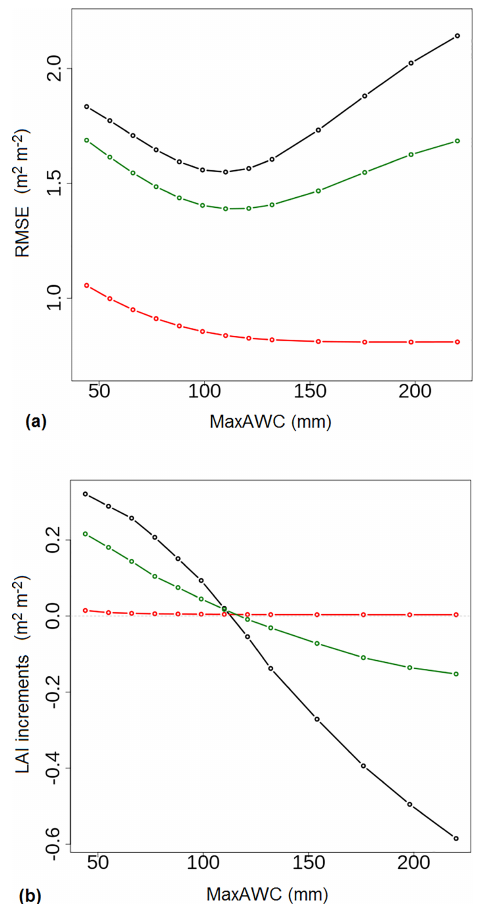
Figure 4. Mean cost function values vs. MaxAWC across all 45 départements of (a) inverse modelling and (b) LDAS tuning experi- ments for three different optimisation periods: (red) start of growing period (from 1 March to LAI max date); (green) peak LAI (dates for which LAI > 0.5 LAI max ) ; (black) senescence (from LAI max date to 31 July). Inverse modelling is based on the minimisation of LAI RMSE (Eq. 11). LDAS tuning is based on the minimisation of the median LAI analysis increment (Eq. 2).